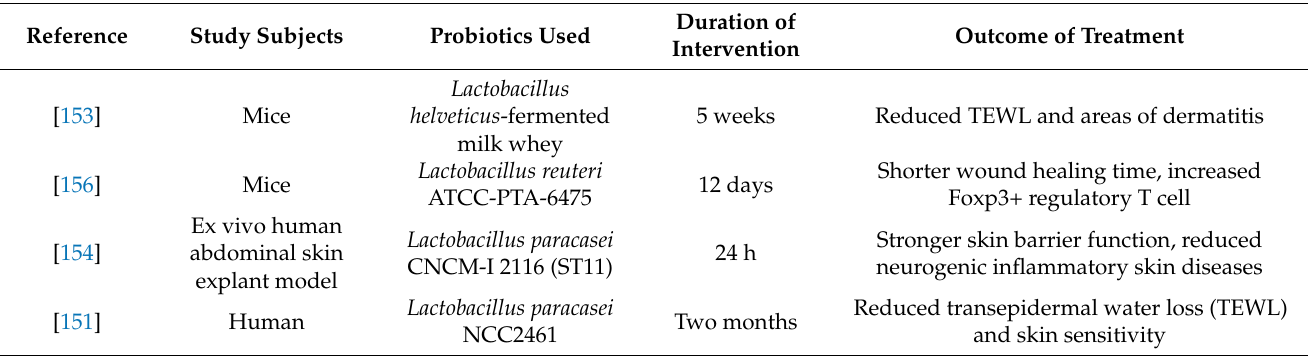
Table 1. Existing evidence of the relationship between probiotic supplementation and their effects on skin health and